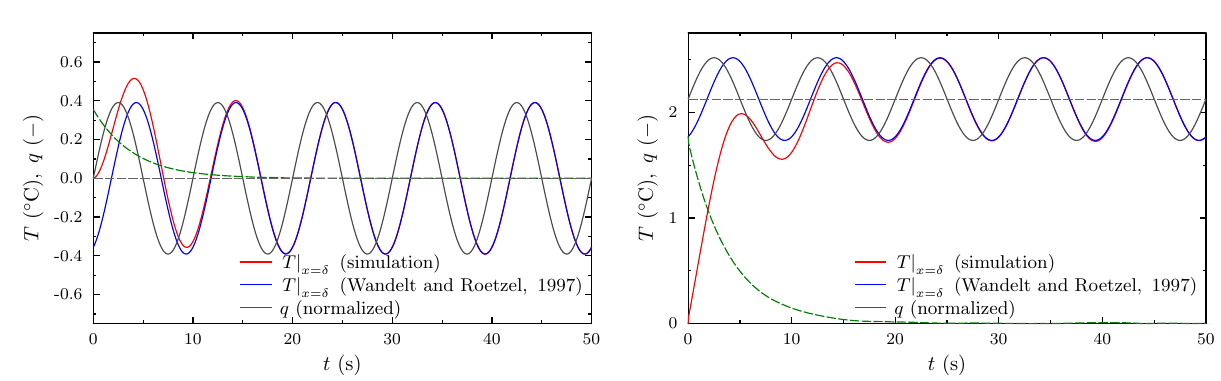
Fig. 3. Temperature response on the surface of the plate (red line) to the harmonic oscillating heat flux (black line), and a comparison with oscillations corresponding to the Wandelt-Roetzel solution (blue line, and the green dashed line represents the di ff erence between them) for heat transfer coe ffi cient 1000 Wm − 2 K − 1 . The plate 1 mm in width is made from stainless steel. Heat transfer coe ffi cient α δ is 3 Wm − 2 K − 1 . The amplitude of the heat flux oscillations is 1000 Wm − 2 , with a zero mean value (left), in comparison with a dependency with a mean value of 2000 Wm − 2 (right).